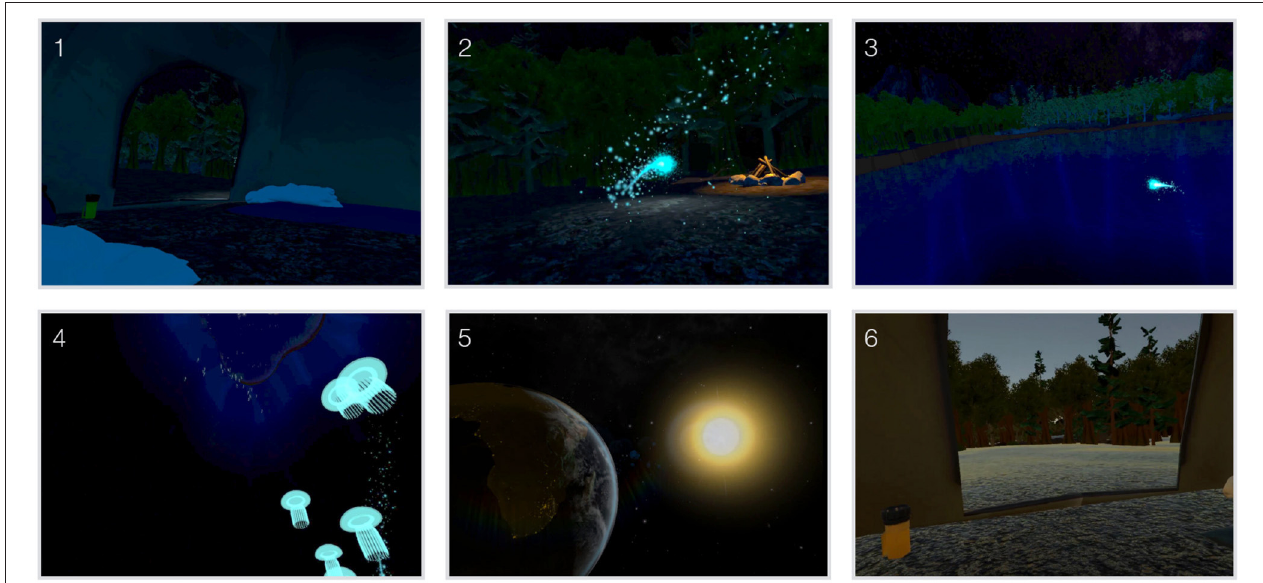
FIGURE 2 | A summary of the virtual journey through “AWE.” . (1) The immersant finds themselves in a tent at a campsite. (2) The magical Sprite creature lures the immersant out of the tent to explore the night forest. (3) Following the Sprite, immersant takes a leap of faith into the lake, (4) where they descend down passing by deep water creatures. (5) The bottom of the lake opens into space where the Earth and Sun appear in a dramatic reveal. (6) After orbiting around the Earth, the immersant finds themselves back in the